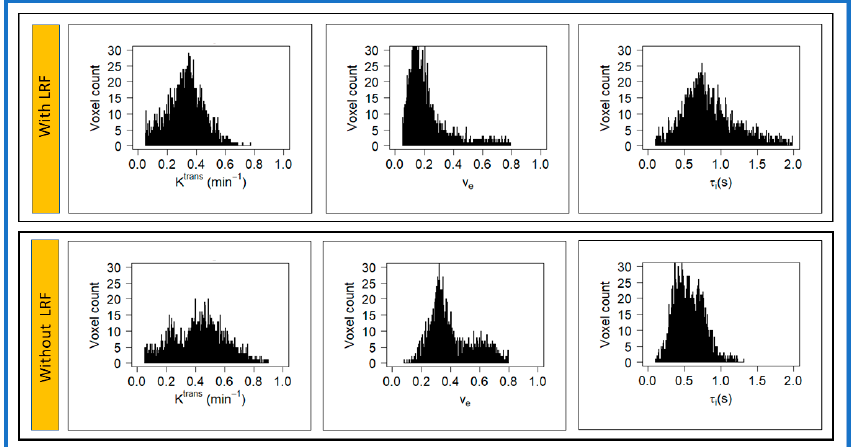
Figure 6. Representative voxel value distribution of volume transfer constant (Ktrans), extravascular extracellular space volume fraction (ve), and mean lifetime of intracellular water protons ( τ i) in a patient with and without LRF of nasopharyngeal cancer (Figure 4). Ktrans and ve values trended higher in a patient without LRF as compared with a patient with LRF. By contrast, τ i values trended higher in a patient with LRF as compared with a patient without LRF.